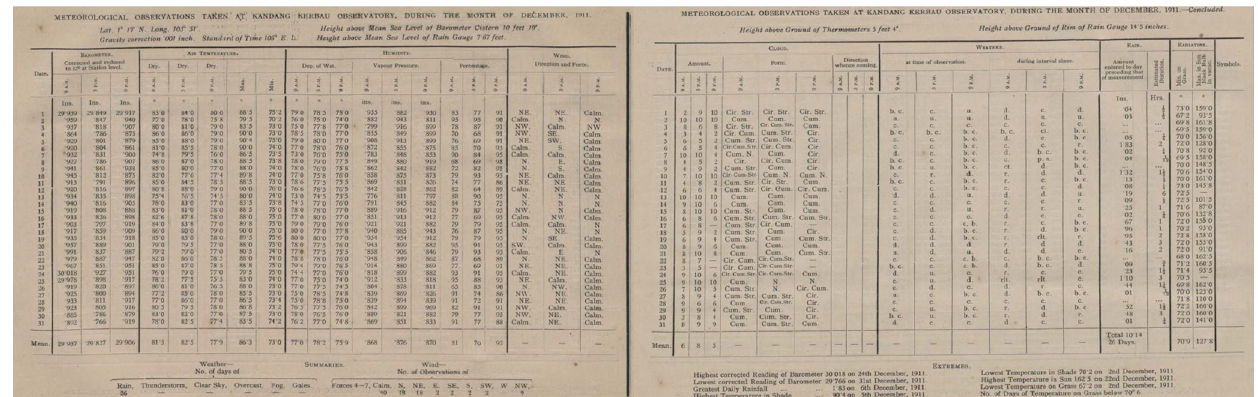
Figure 3. Meteorological observations taken at Kandang Kerbau Observatory, December 1911, published in the Straits Settlements Govern- ment Gazette , 11 October 1912, pp.